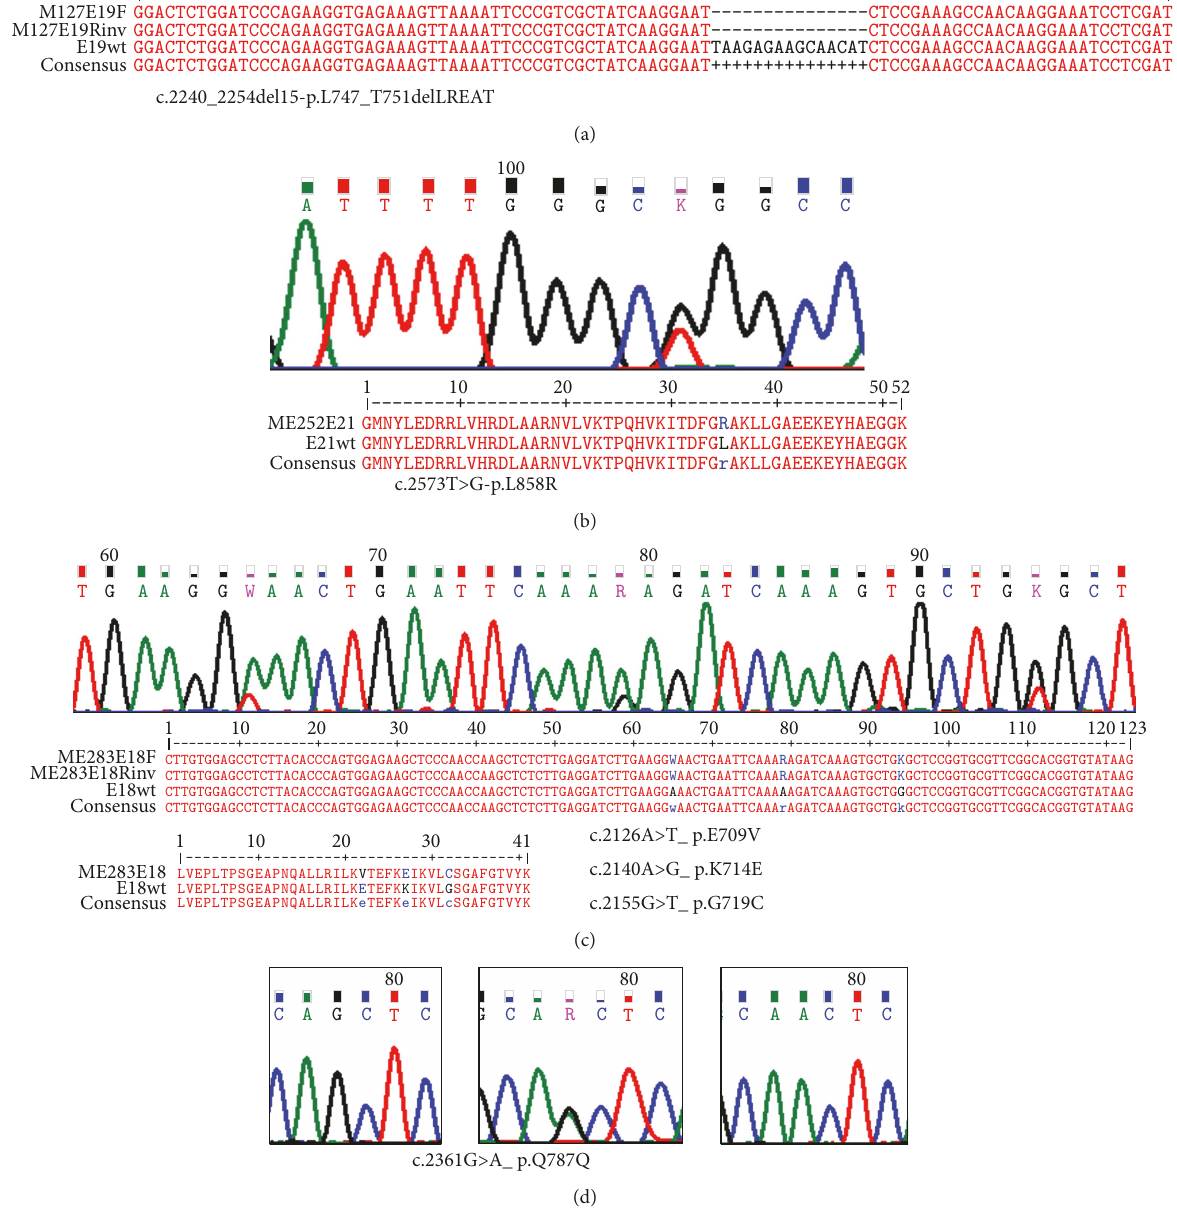
Figure 2: Examples of observed mutations: (a) exon 19 deletion; (b) missense mutation L858R in exon 21; (c) simultaneous triple point mutations in exon 18; (d) the most frequent coding silent substitutions